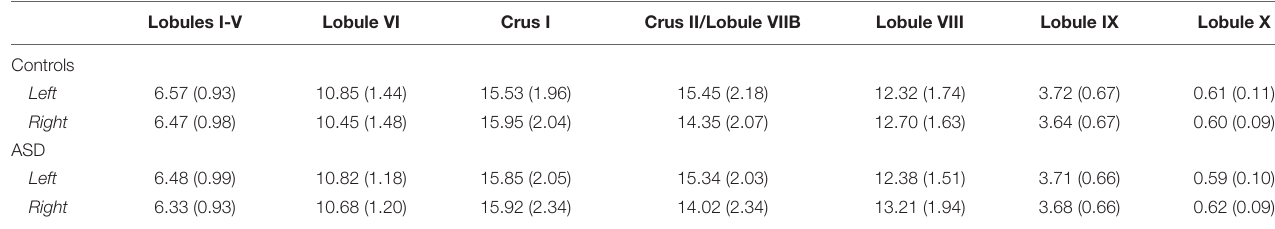
TABLE 2 | Volume of lateralized regions of interest